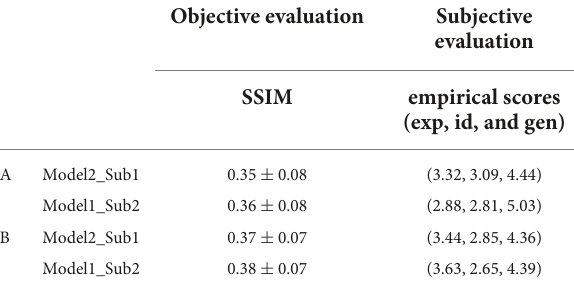
TABLE 7 Quantitative evaluation of seen (A) and unseen (B) face image reconstruction from inter-subject functional magnetic resonance imaging (fMRI)